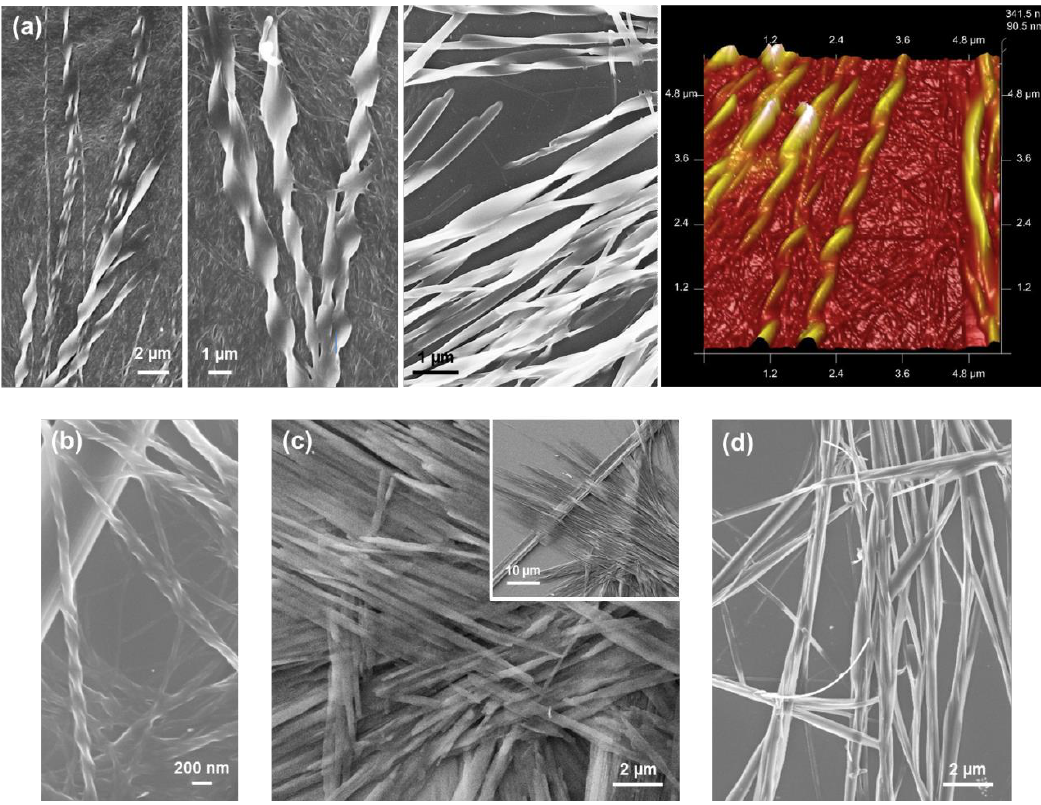
Figure 12. ( a – d ) SEM micrographs and ( a ) AFM image (5.4 × 5.4 µm 2 ) of the structures obtained at room temperature from TFA·FF-OFm solutions in ( a ) 1:4 HFIP:MeOH, ( b ) 1:4 DMF:MeOH, ( c ) 1:4 HFIP:chloroform mixtures (1 mg/mL in all cases), and ( d ) pure HFIP (5 mg/mL).